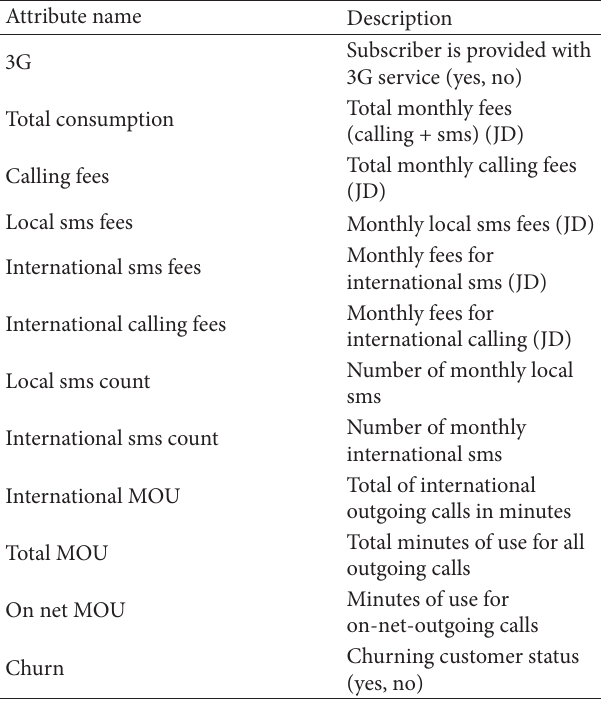
Table 2: List of attributes.